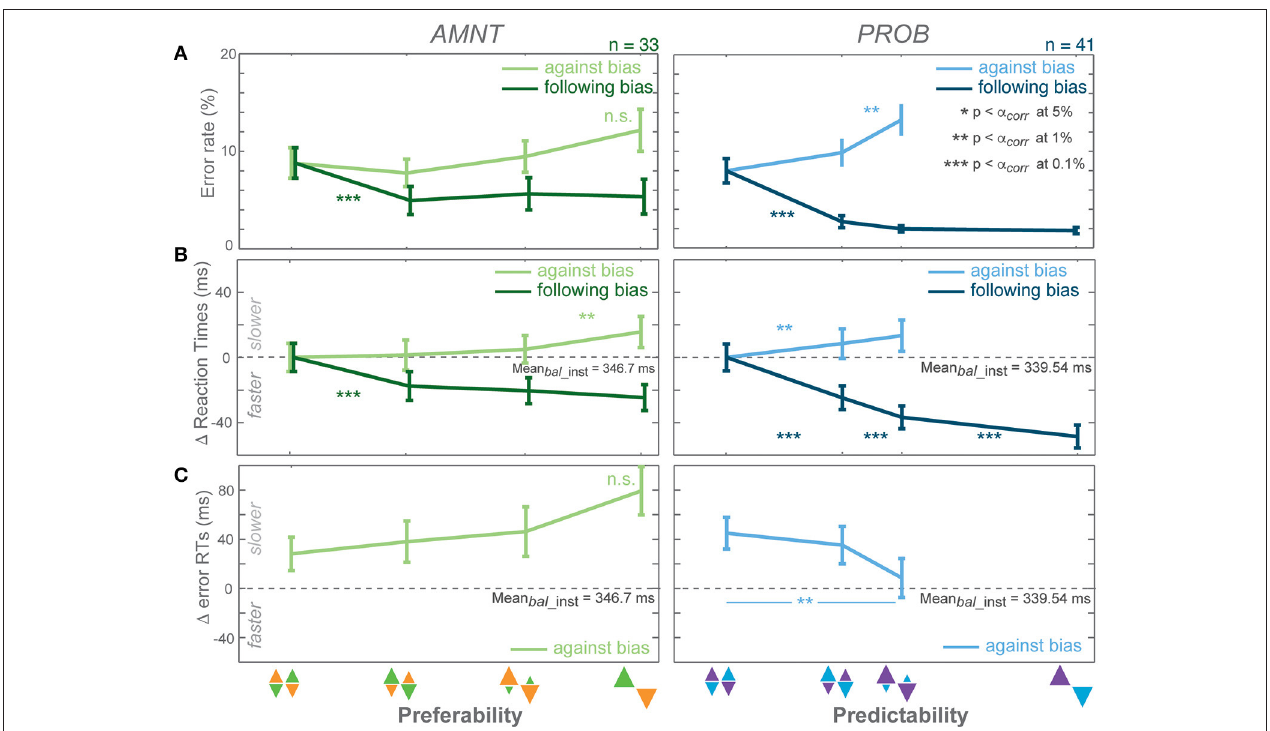
FIGURE 2 | Biasing effects on instructed responses. (A) Average error rates (ER): proportion of error trials committed during the reach period, (B) average reaction time (RT) difference from average RTs in instructed trials of zero-bias condition of each task in all bias levels in AMNT (left) and PROB (right) tasks, (C) average error RT difference (zero line indicates average correct RTs in instructed trials of zero-bias condition of each task). Dark and light colors represent follow and against responses, respectively. Error bars depict standard errors. ( * p < α corr at 5%, ** p < α corr at 1%, *** p < α corr at 0.1%, paired t -test with Bonferroni